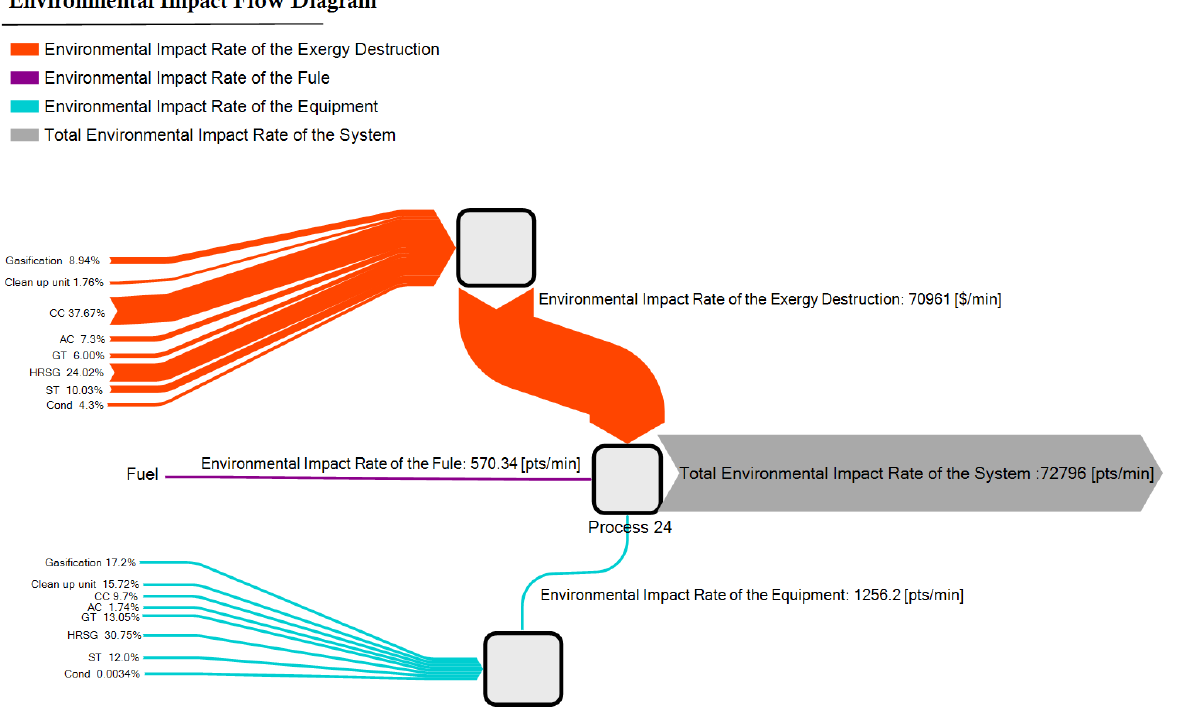
Figure 4. Environmental impact flow diagram of the proposed integrated solar-gasification cycle (ISGC) system. AC: Air compressor; CC: Combustion chamber; Cond: Condenser; GT: Gas turbine; HRSG: heat recovery steam generator; ST: steam turbine.